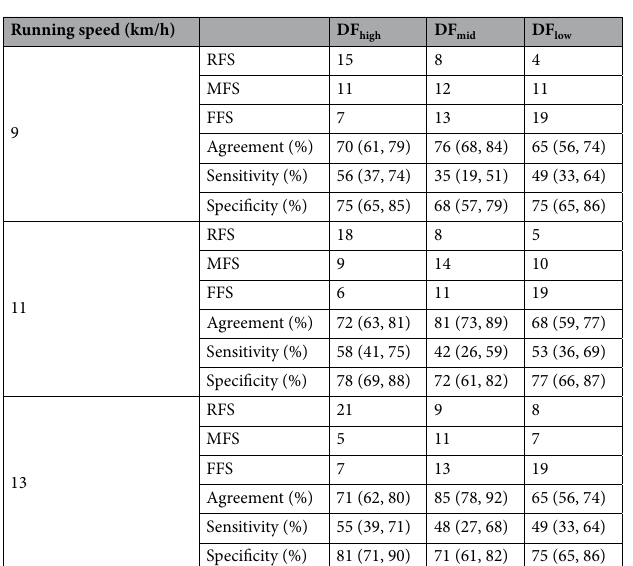
Table 2. The average (over speed and group) agreement, sensitivity, and specificity were 73, 49, and 75%, respec- tively.